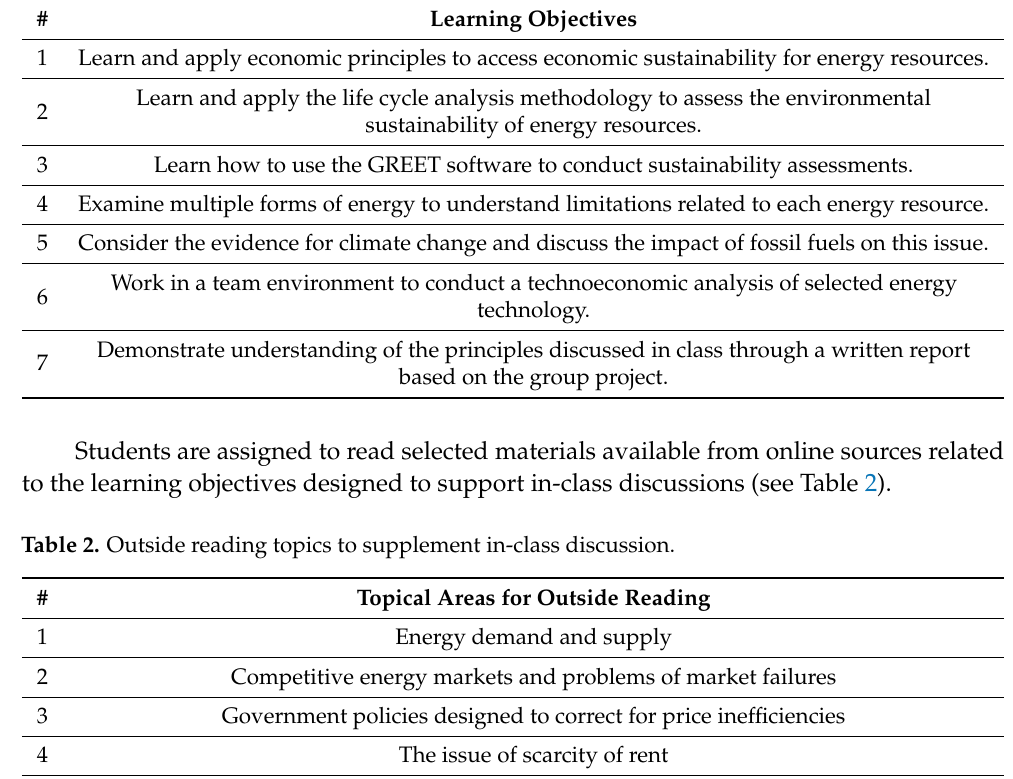
Table 1. Energy economics learning